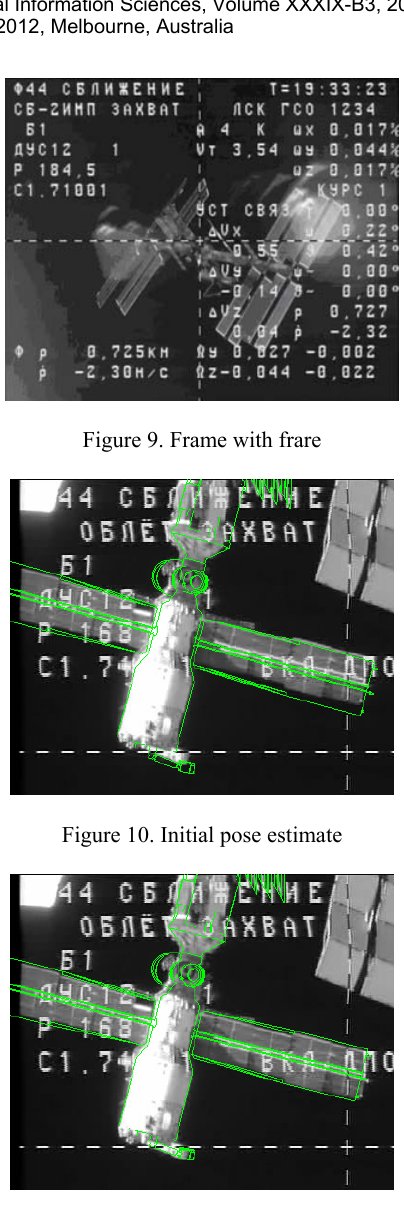
Figure 11. Contour obtained from found